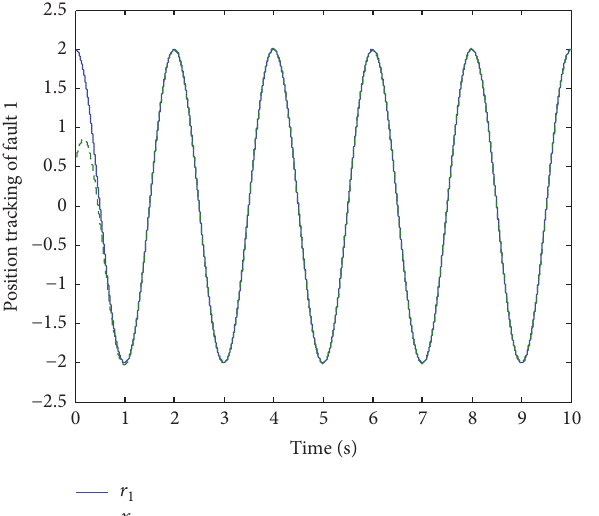
Figure 15: Actual value 𝑥 1 and tracking state of input signal 1.